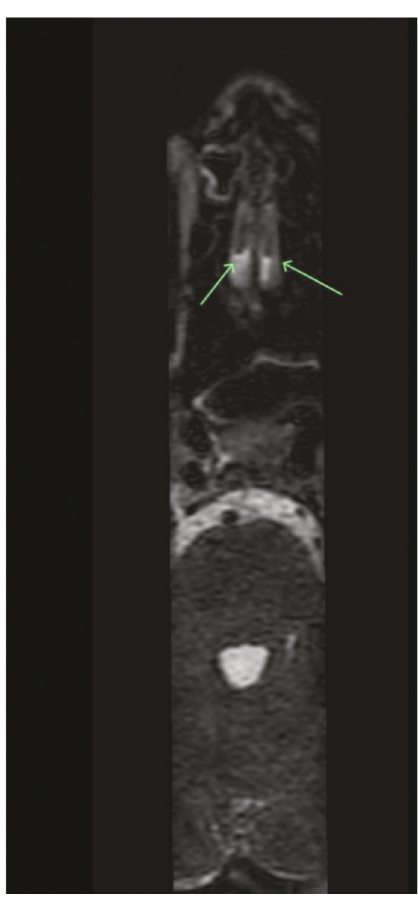
Figure 5: Transverse view of MRI anosmia protocol illustrating the presence of a normal volume olfactory bulb but absent olfactory tracts.